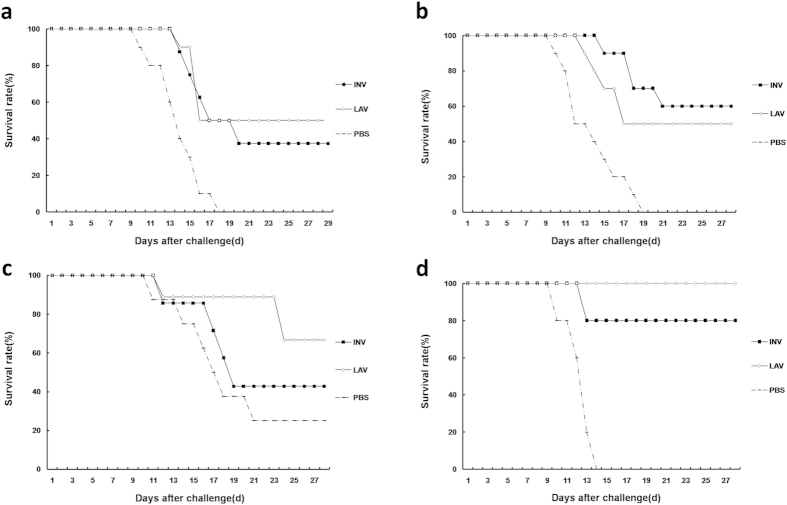
The immunized mice were intracerebrally (i.c.) challenged with a lethal dose of DENV 1-4.The results are expressed as the survival rates. (a–d) Challenged by DENV1-4, respectively.